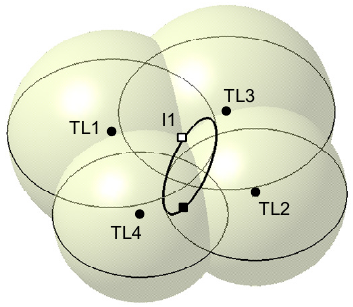
Figure 1. Multilateration principle.